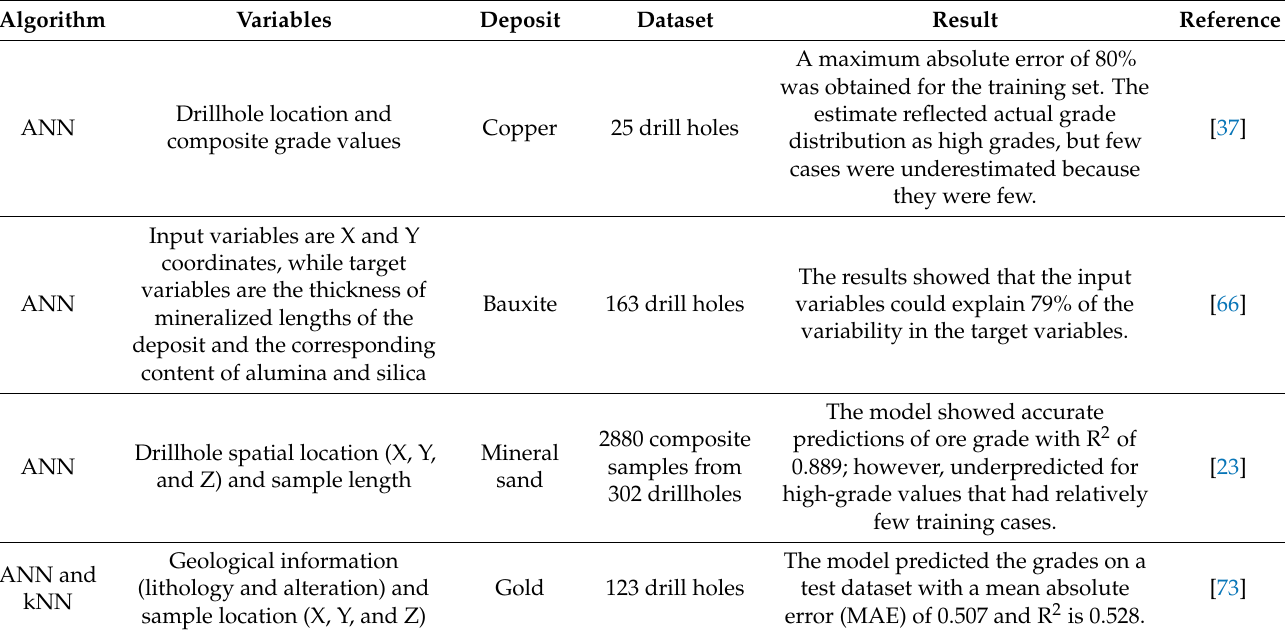
Table 3. Sample case studies of ANN-based mineral resource